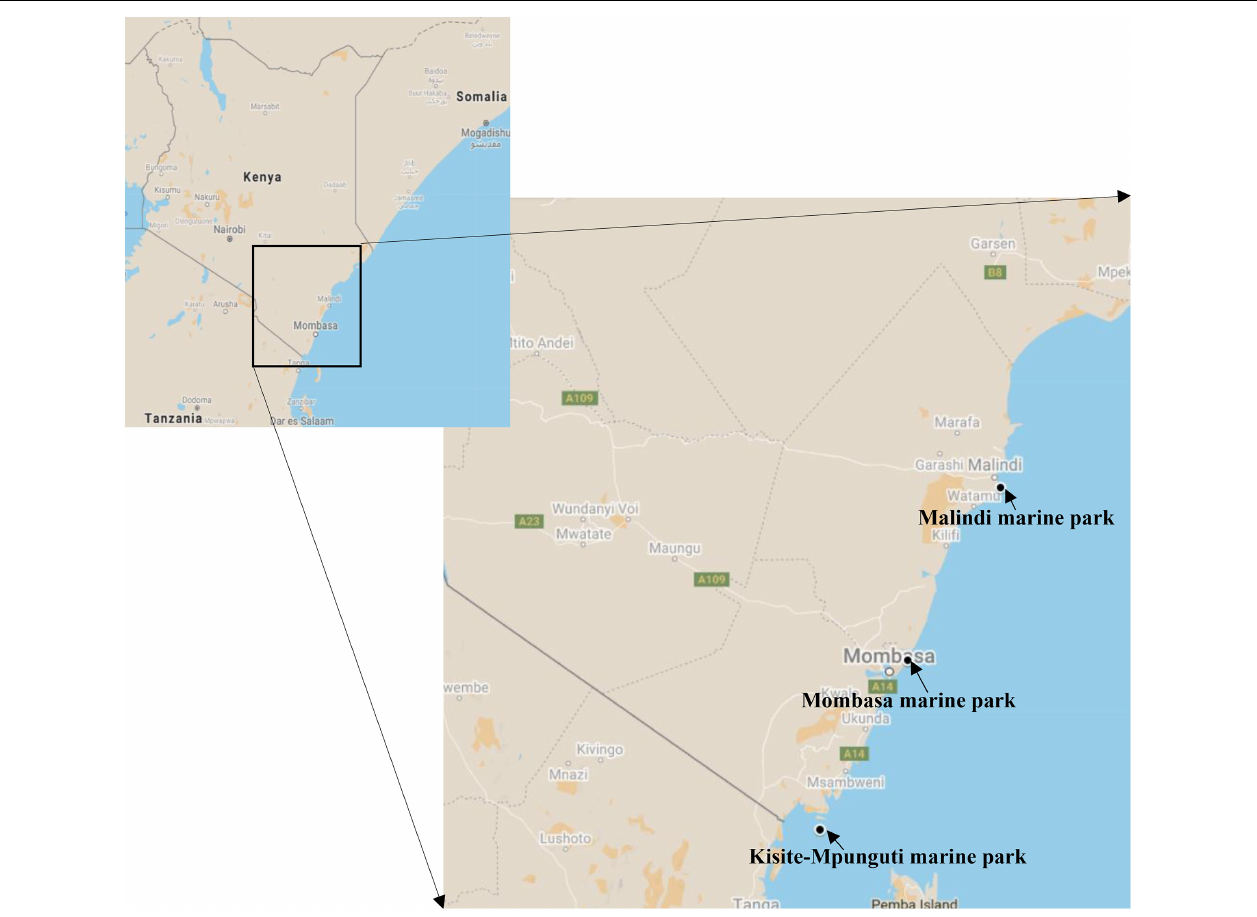
FIGURE 1 | Map showing the location of the coral reef sites sampled for this study of the Kenyan microbiome. Source: Google